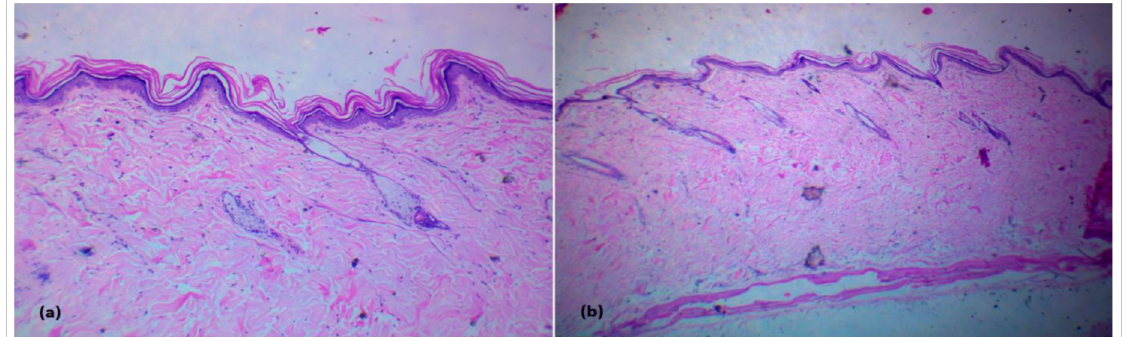
Figure 10. H&E sections: ( a ) normal skin; ( b ) skin treated with LO-LNCs with no signs of inflamma-